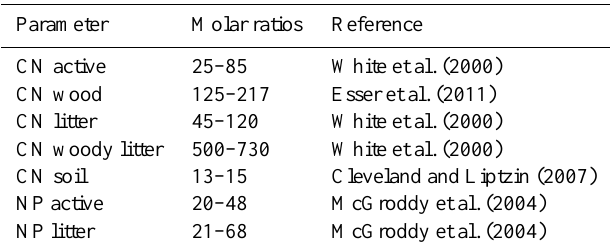
Fig. C2. The simulated change in land carbon storage in the parame- ter pertubation simulations. Shown are the median (bold black), the range between the 10th and 90th percentile (color), and the range between mininum and maximum for each ensemble (grey). Table C1. Ranges used to constrain the probability functions of the stoichiometric parameters in the